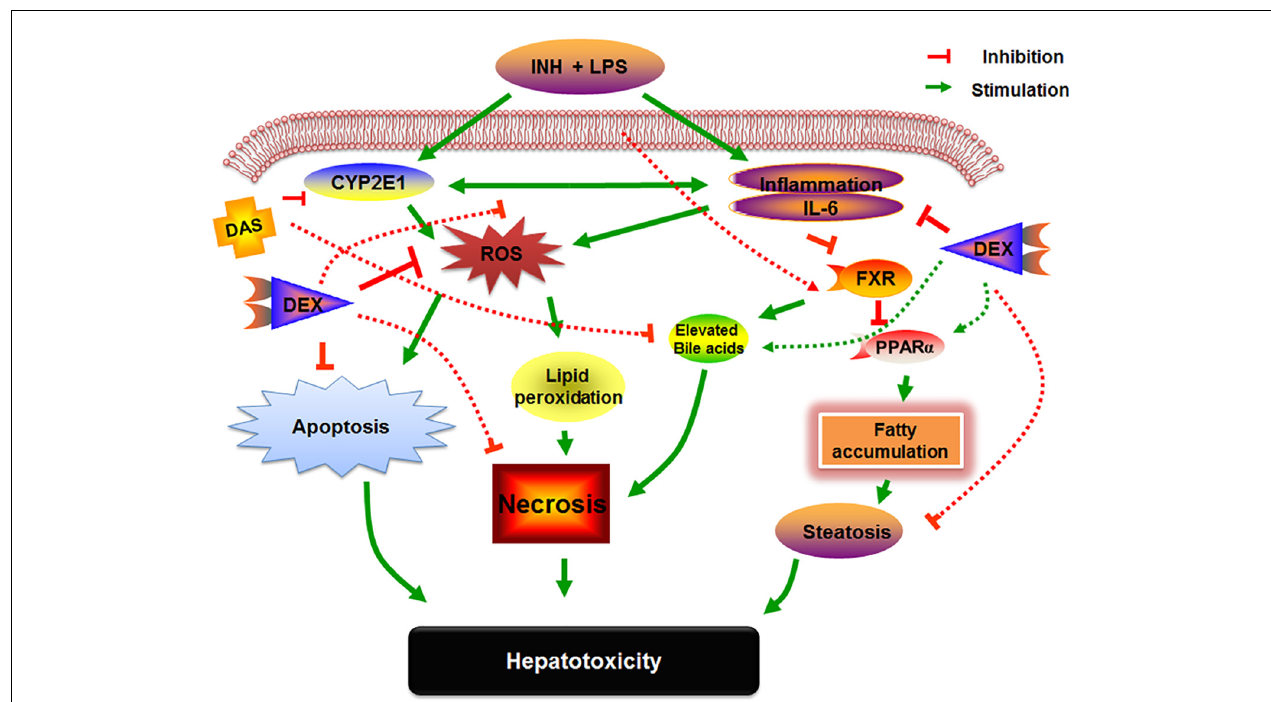
FIGURE 8 | Schematic representation indicating the suggested mechanisms by which INH/LPS-induced hepatotoxicity and the DAS and DEX possible mechanistic intervention for liver protection in INH/LPS liver injury